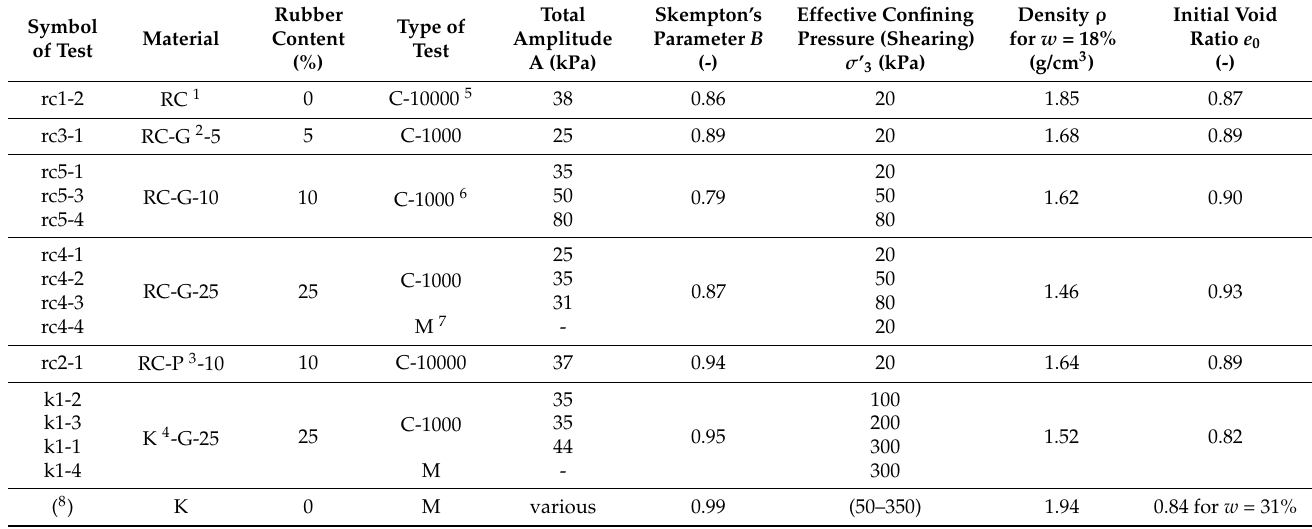
Table 3. Characteristics of tests conducted within the